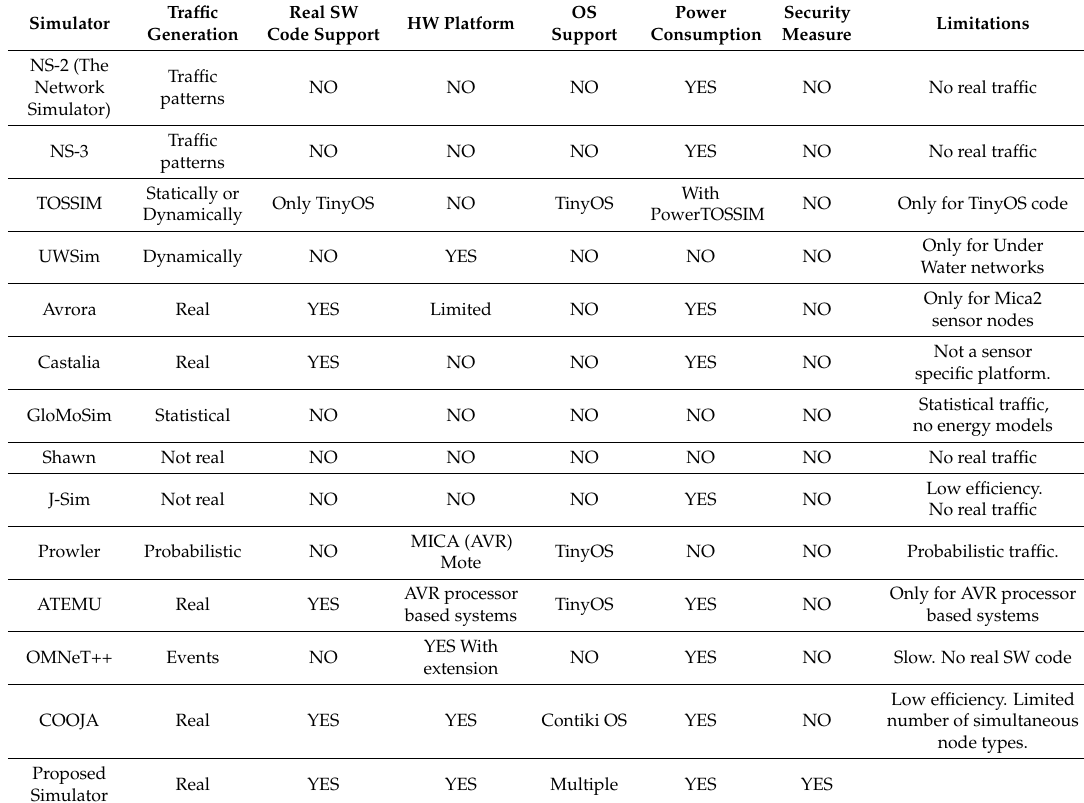
Table 1. Survey of